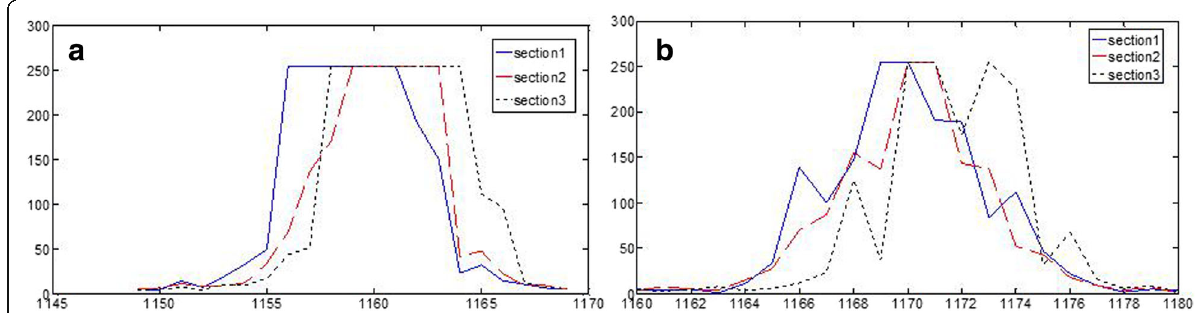
Fig. 4 Cross-sectional grayscale distribution of light stripe images. a The grayscale distribution on paper plane b The grayscale distribution on